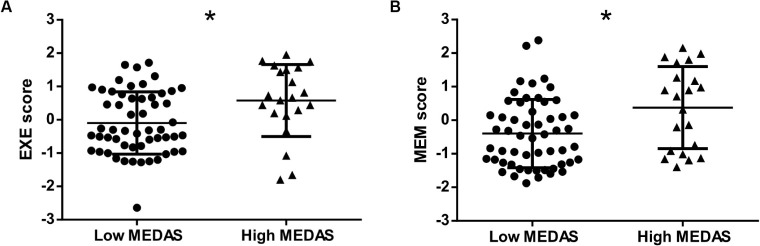
Cognitive scores by adherence to the Mediterranean diet (MedDiet). Both executive functioning scores (A) and memory scores (B) were statistically higher in those with high adherence to the MedDiet [high Mediterranean Diet Assessment Screener (MEDAS)]. EXE, executive functioning; MEDAS, Mediterranean Diet Assessment Screener; MEM, memory. Asterisks indicate that cognitive scores reached statistical significance in participants with low MEDAS vs. participants with higher MedDiet adherence (p < 0.05).